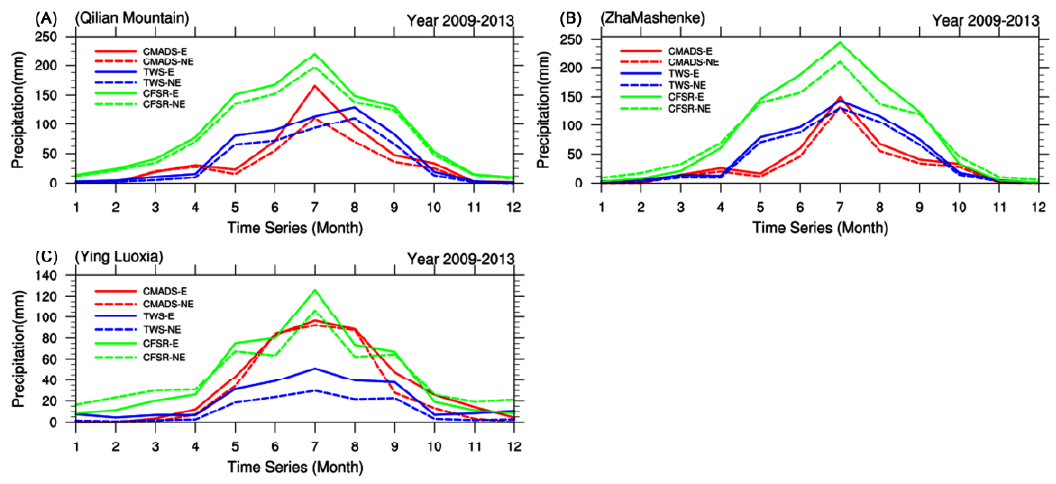
Figure 15. Precipitation distribution of CMADS, CFSR, and TWS dataset with (-E) and without (-NE) the elevation module at ( A ) Qilian Mountain, ( B ) ZhaMashenke, and ( C ) Ying Luoxia stations.